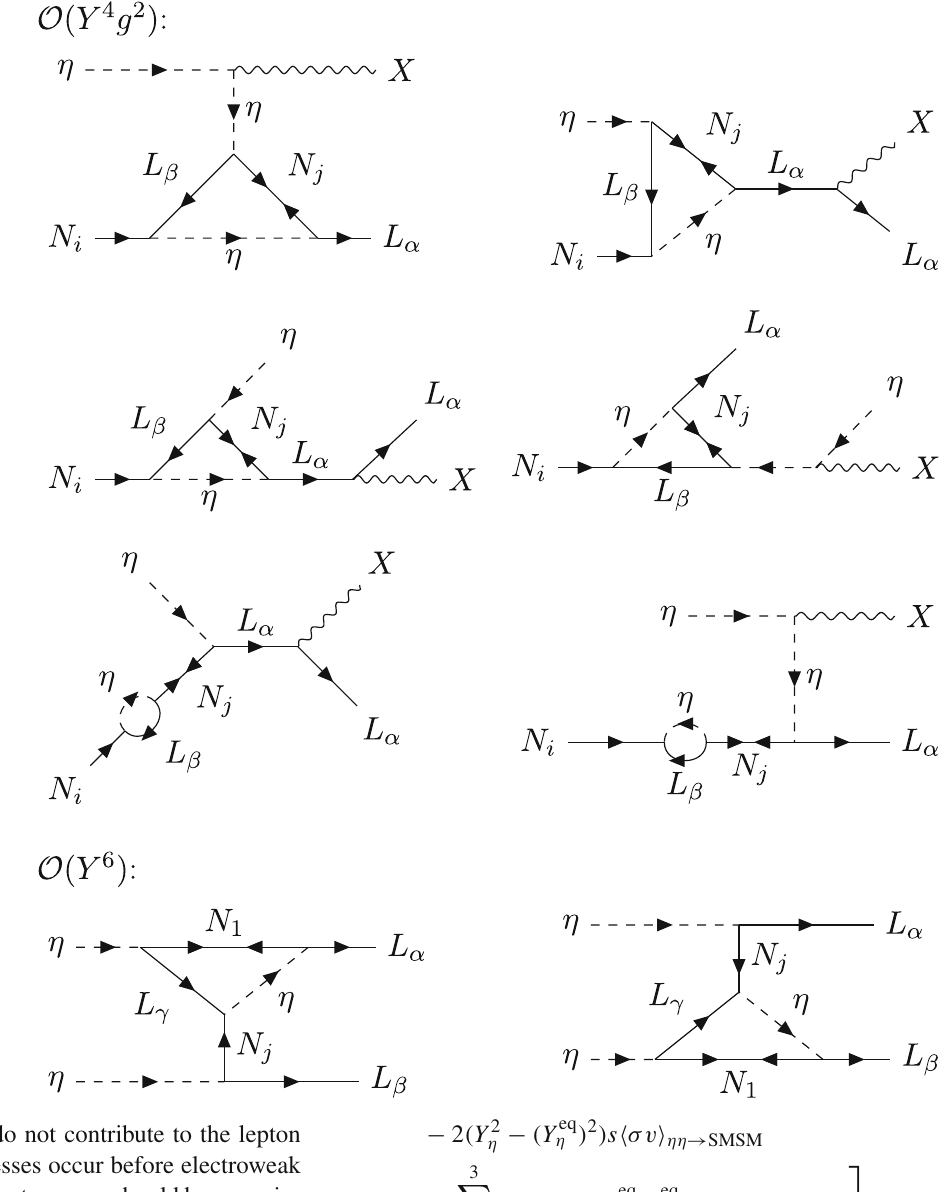
Fig. 2 1-loop diagrams contributing to the asymmetry arising from the interference at O ( y 4 g 2 ) and O ( y 6